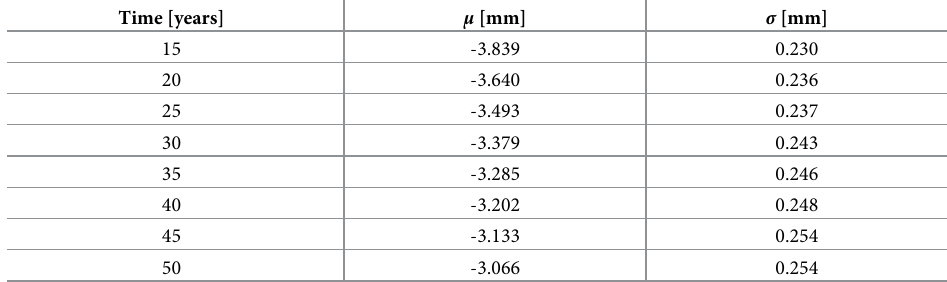
Table 5. Chemically destroyed depth d 0 as a reliability process for parameters of log-normal distribution ( μ , σ ) with time influence.